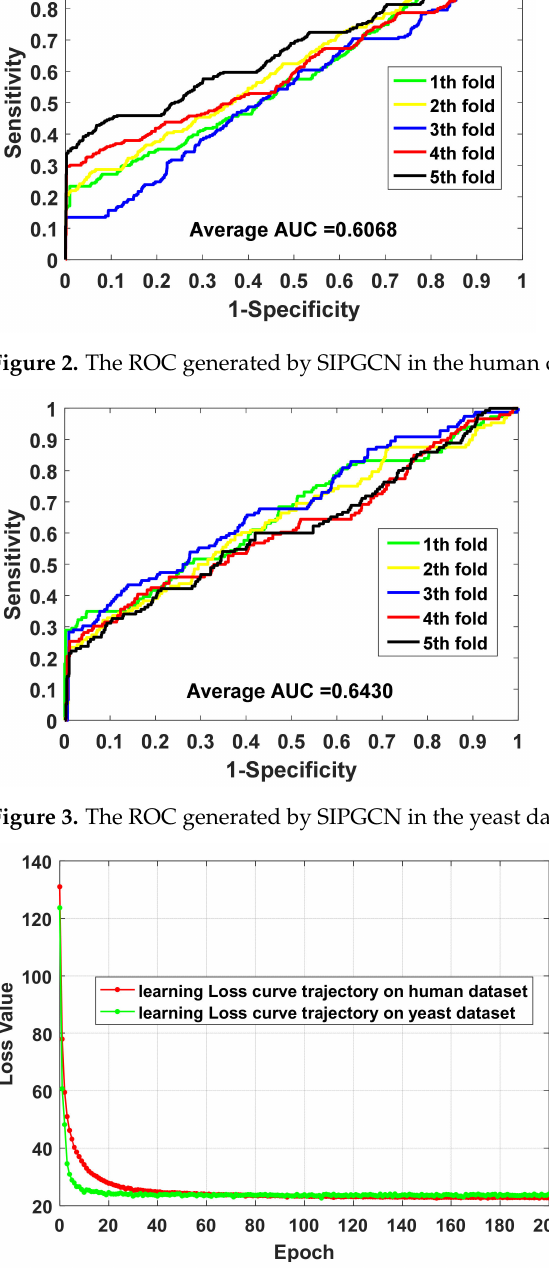
Figure 4. Learning curve trajectory generated by SIPGCN in the human and yeast data